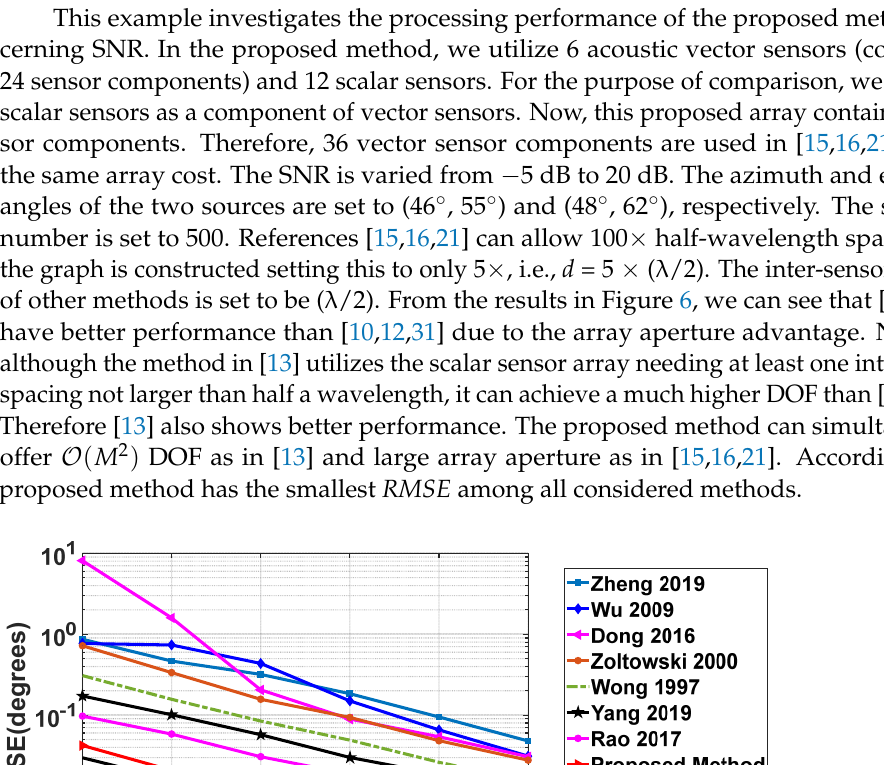
Figure 7. RMSE versus N . 4.4. Runtime vs. the Number of Sensor Components In this experiment, we compared the runtime required for each algorithm to run once in MATLAB 2022b on the same computer. The results are shown in Figure 8. For the pur- pose of comparison, we consider scalar sensors as a component of vector sensors. Other conditions are the same as Experiment 2, except that the total number of sensor compo- nents changes from 24 to 72. From Figure 6, it can be seen that the running time of the proposed method increases with an increase in the total number of sensor components.